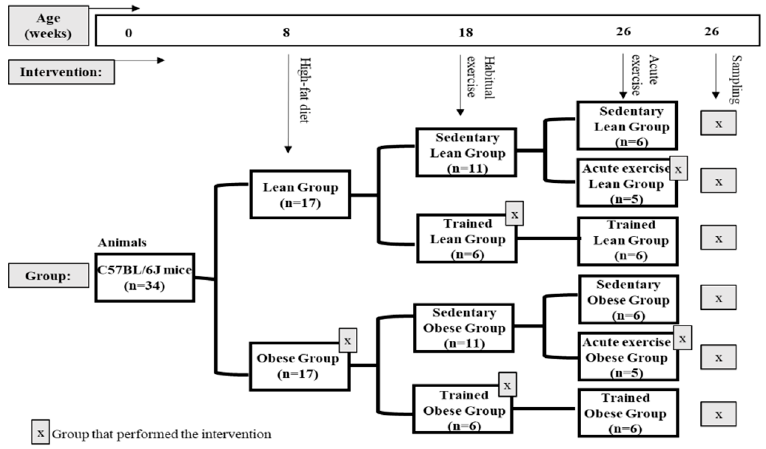
Figure 1. Schematic diagram of the experimental design of the study.